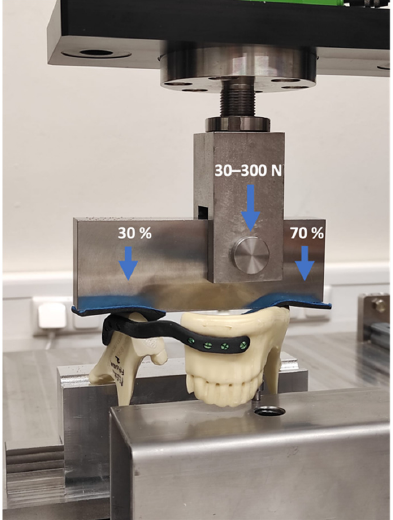
Figure 2. Segmentation, 3D reconstruction, and virtual planning of the mandibular defect size and plate design. ( A – C ), Digital image of the scanned polyurethane mandible before and after defining the defect size and planning the positioning of the resection guides. ( D – F ), Assessment of the adequate dimensions for patient-specific titanium and polymer plates using the medical modeling software (Geomagic© Freeform Plus© from 3D Systems ©, Rock Hill, SC, USA).